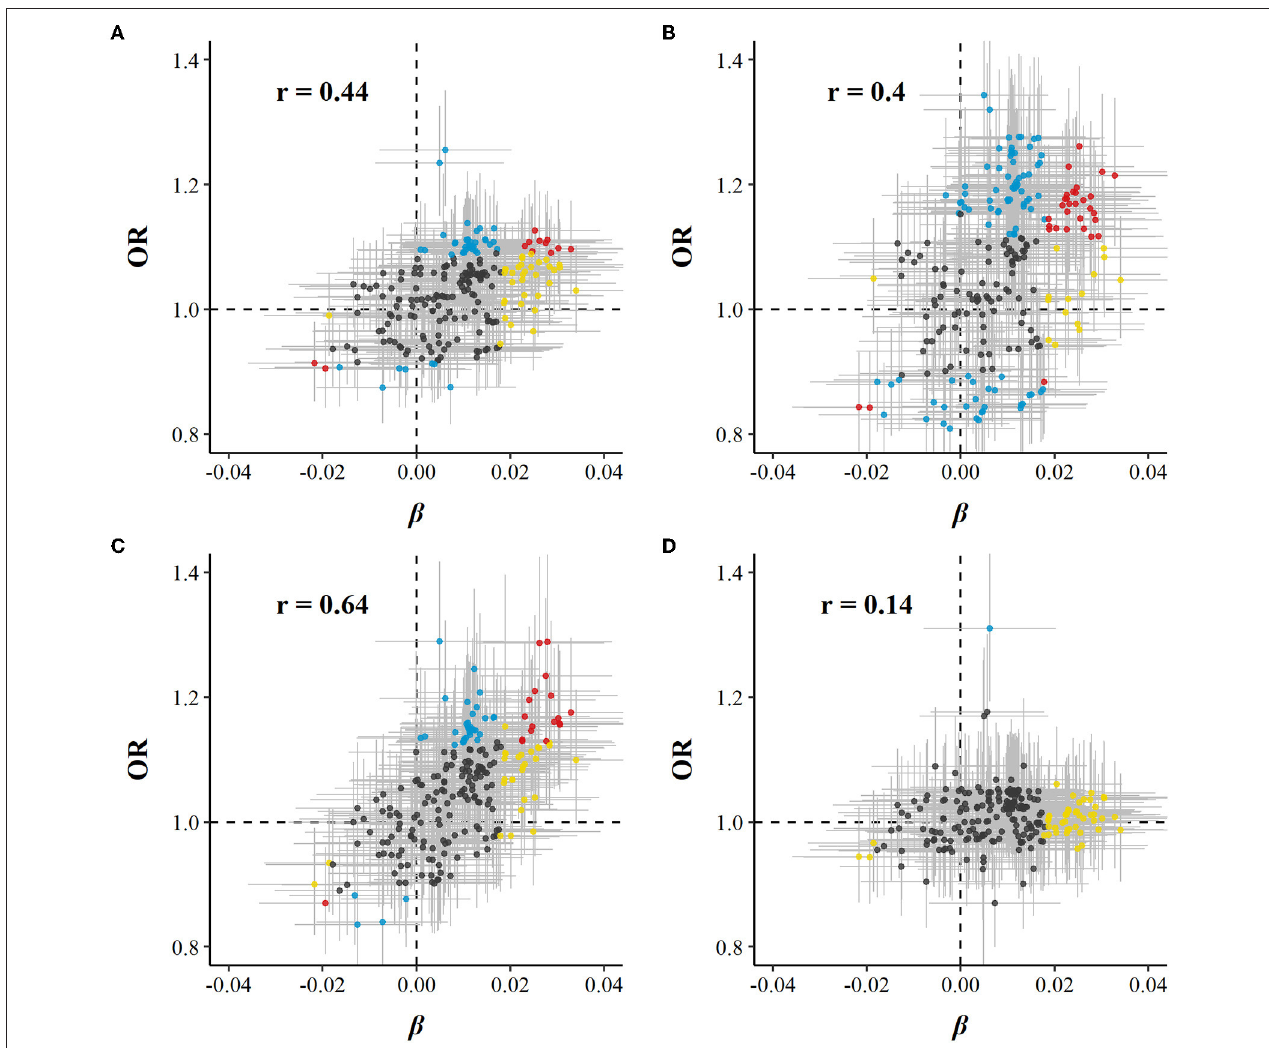
FIGURE 2 | Global comparison of SD differences of 225 log-transformed metabolic markers associated with red meat consumption vs. ORs for (A) CVD, (B) MI, (C) IS, and (D) ICH associated with SD higher log-transformed metabolic markers. Models were adjusted for age, sex, region, education, household income, occupation, marital status, tea-drinking habit, smoking status, alcohol intake, physical activity, self-rated health, fasting time, and frequency of other 11 food groups. Yellow dots represented markers that associated with red meat consumption but not with risk of diseases; blue dots represented markers that associated with risk of diseases but not with red meat consumption; and red dots represented markers that associated with both red meat consumption and risk of diseases, with overlapping dots darker in color. The gray horizontal line and vertical line represented 95%CI of coefficients and ORs, respectively. Pearson correlations of coefficients and ORs were annotated in the upper left